Question: Is the quantity shown trending increasing or decreasing?
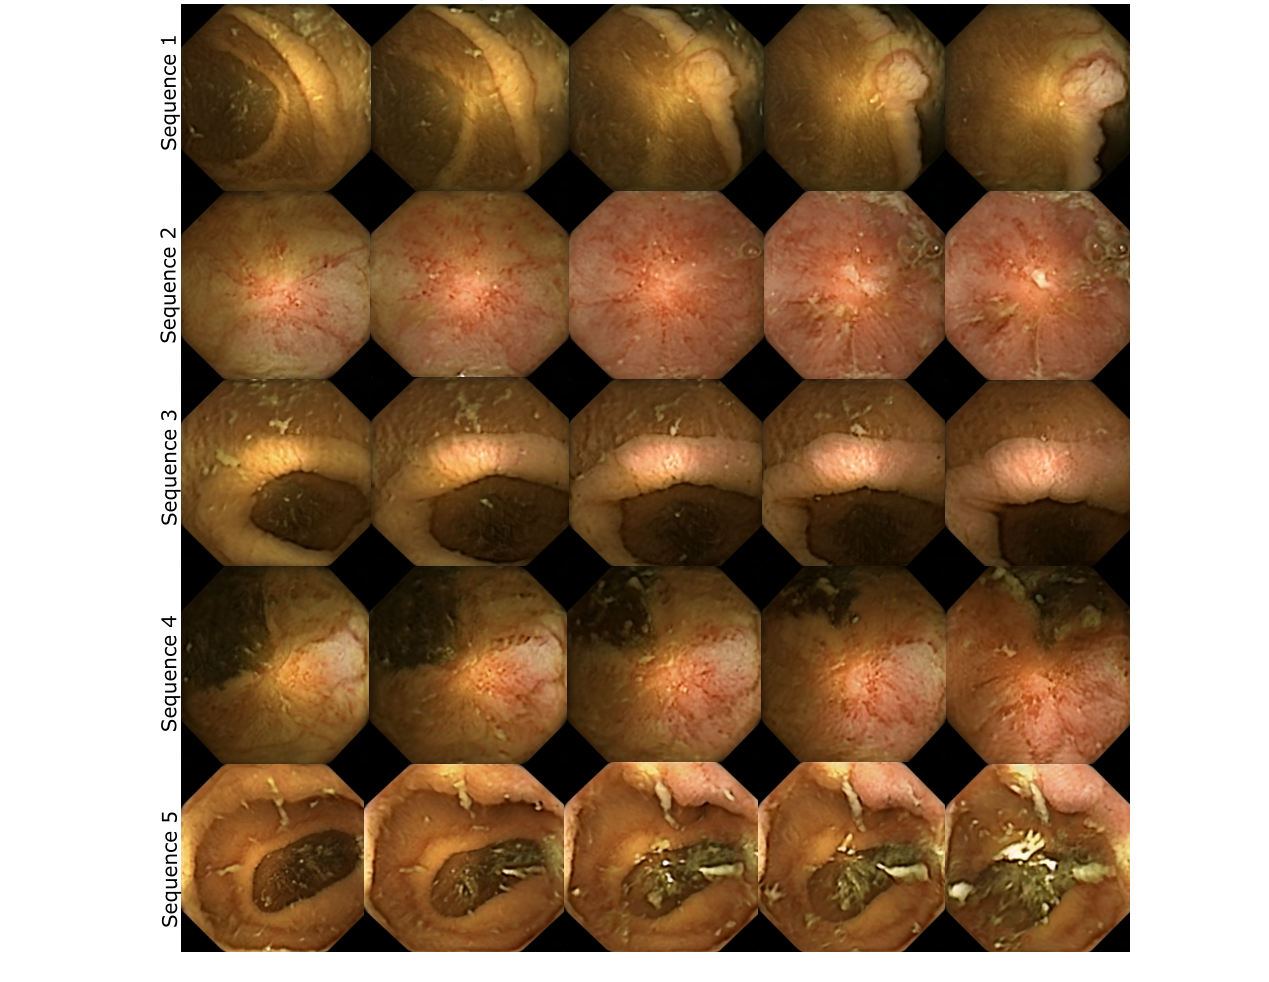
Answer: increasing